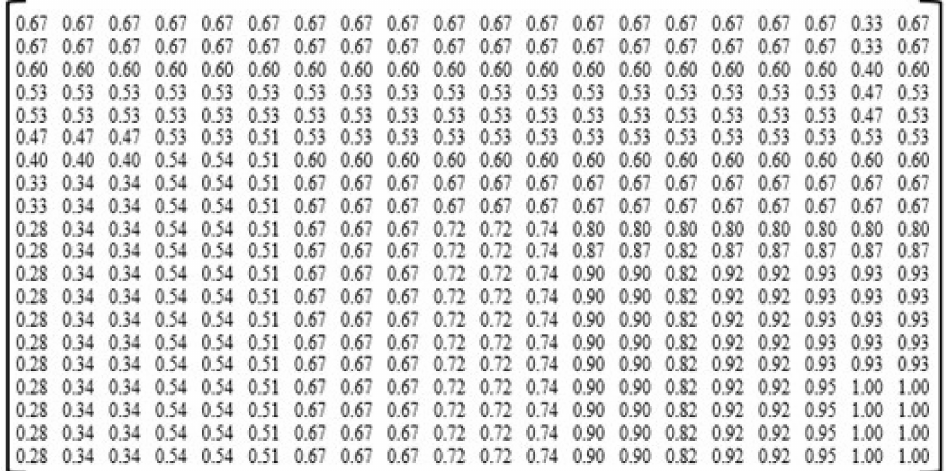
Figure 10. The fuzzy set transformer FTM (the production rule) for the second experiment (Section